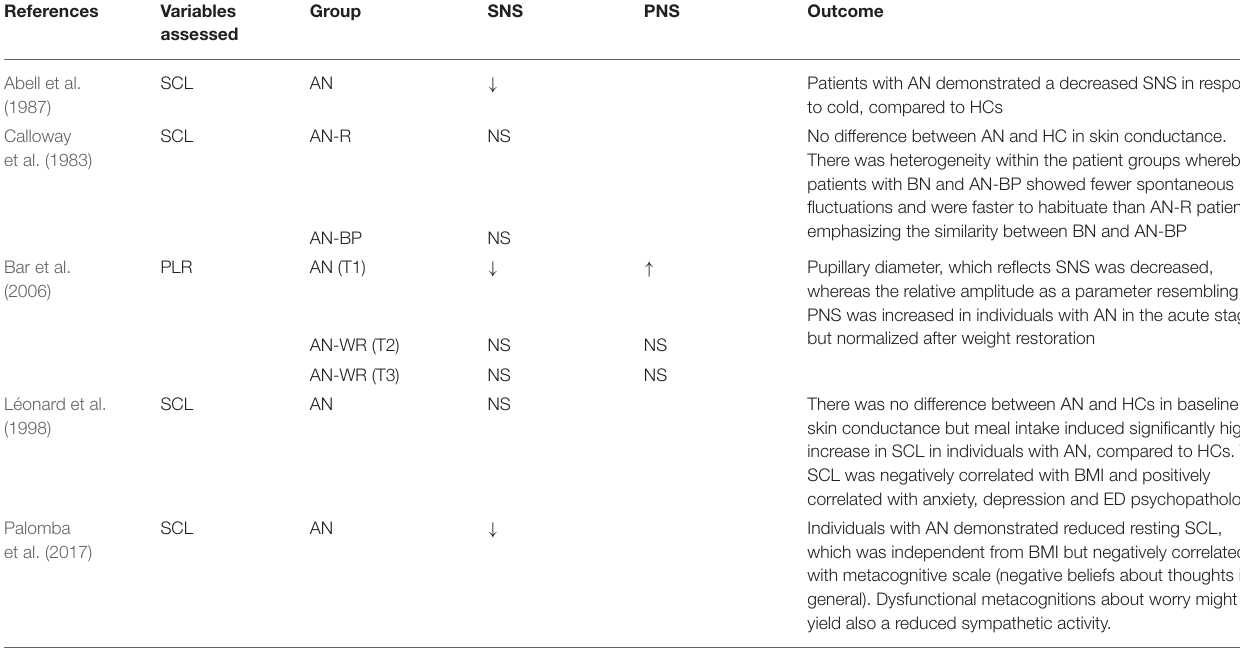
TABLE 6 | Skin conductanc and pupil response, as compared to controls.